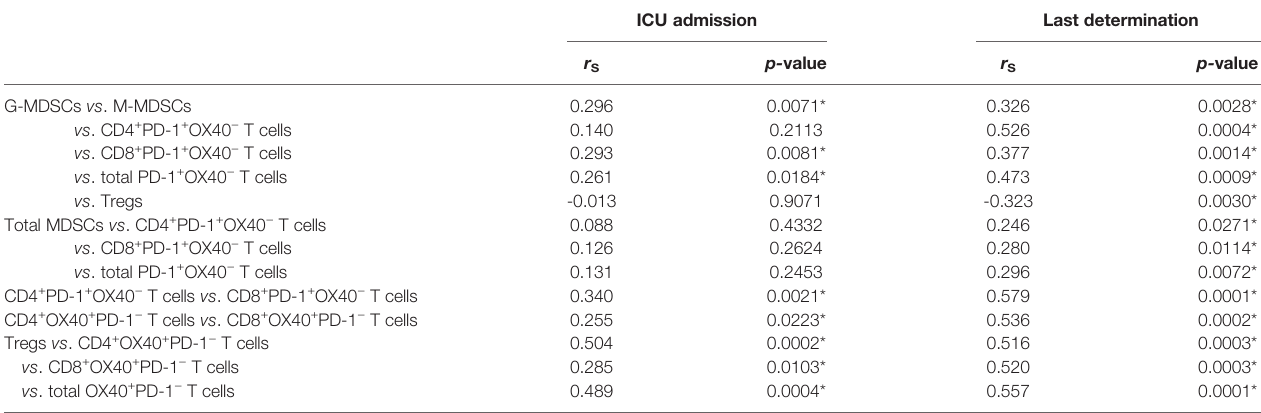
TABLE 2 | Spearman ’ s correlations ( r S ) between cell